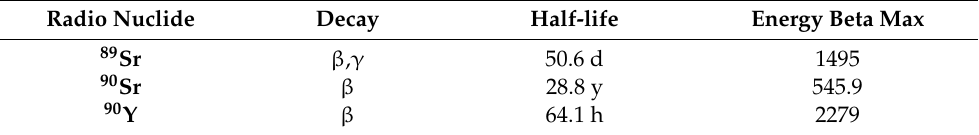
Table 6. Properties of radiostrontium and daughter nuclides. Beta energies in keV. All data from [22]. Radio Nuclide Decay Half-life 89